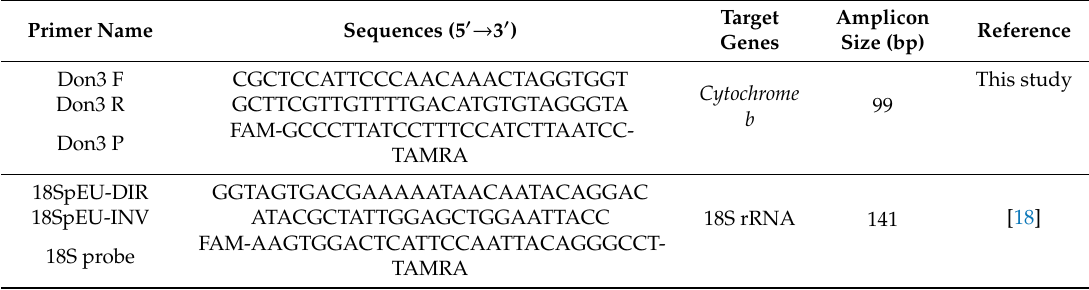
Table 1. Sequences of primers and probes used in this